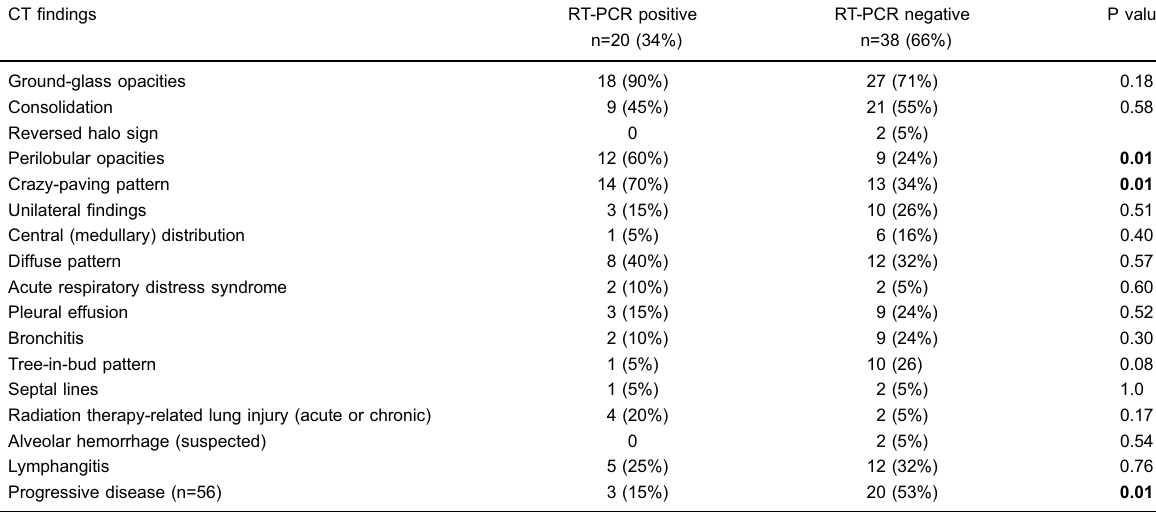
Table 3. Computed tomography (CT) imaging fi ndings according to SARS-CoV2 RT-PCR result.